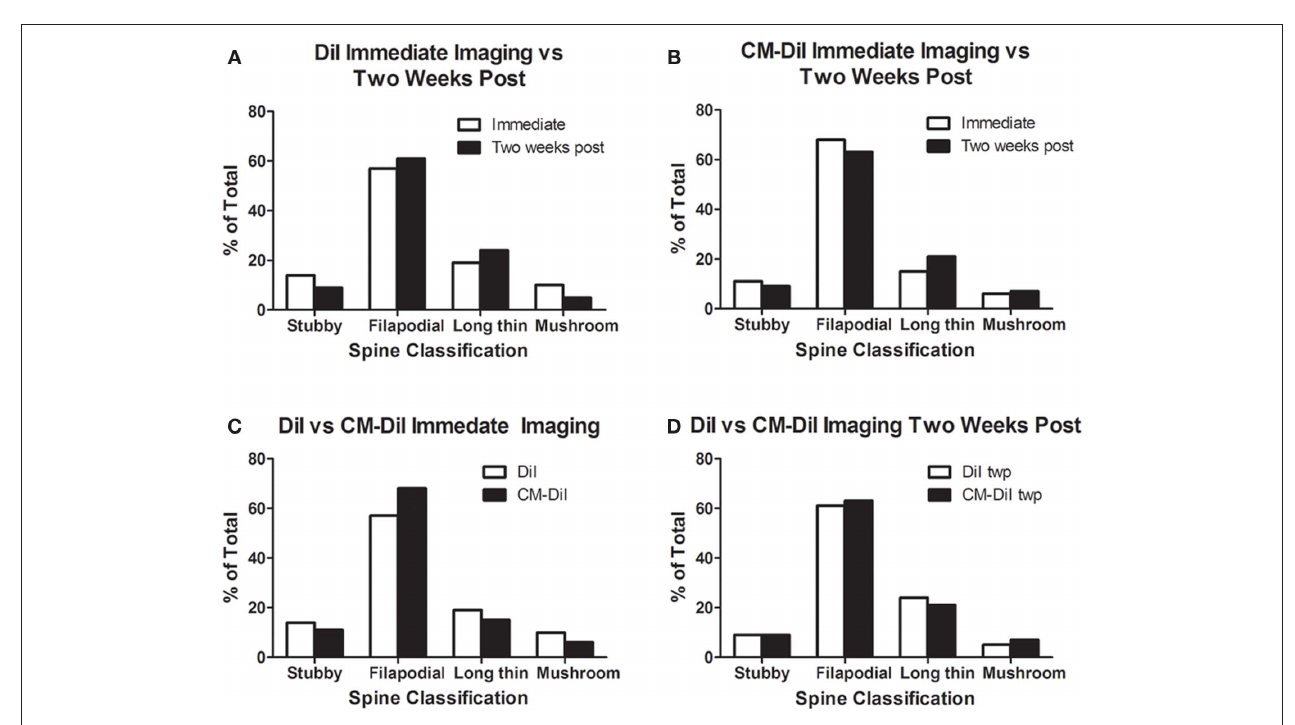
Figure 9 | Spine morphology analysis of permeabilized Dii and CM-Dii treated tissues. (A,B) No significant differences in spine morphology were observed in DiI or CM-DiI treated tissues of permeabilized tissues between images captured